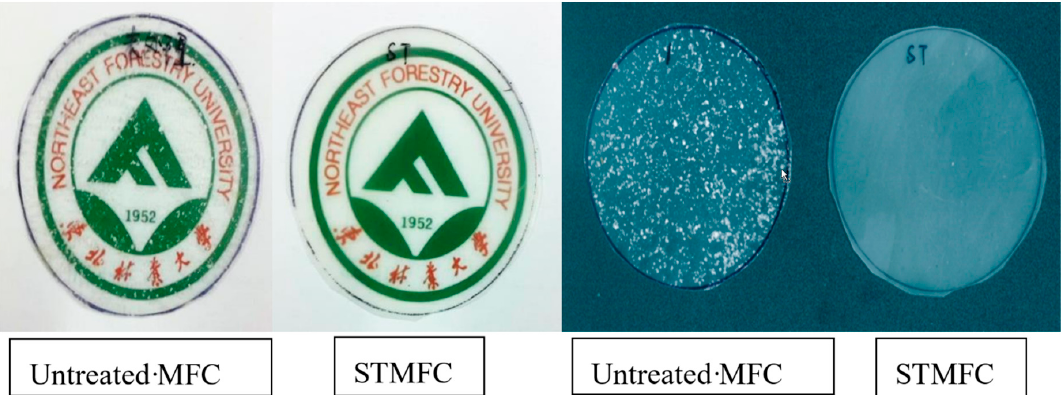
Figure 5. Scanning images of LLDPE composite films enhanced by 10 wt% MFC with different processing methods.